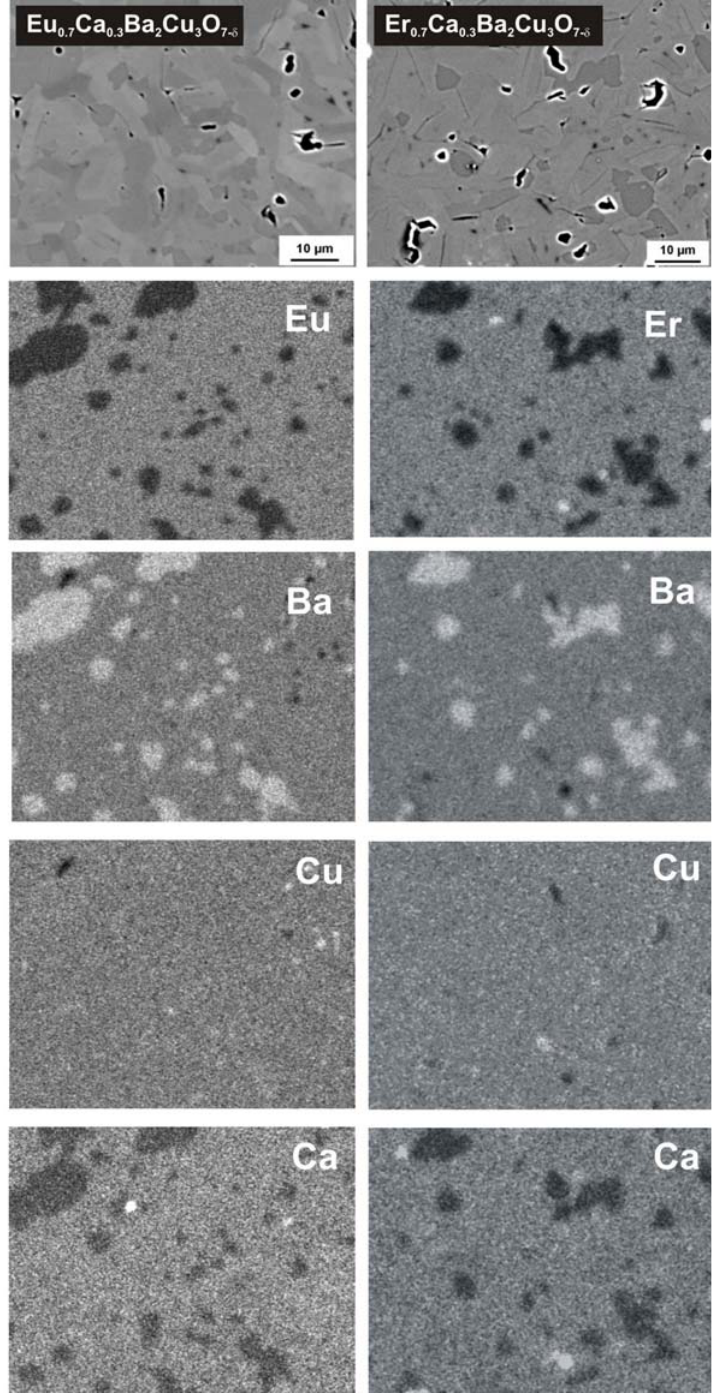
Fig. 3 Backscattering electron image of RE 0.3) samples, showing the composition map of different